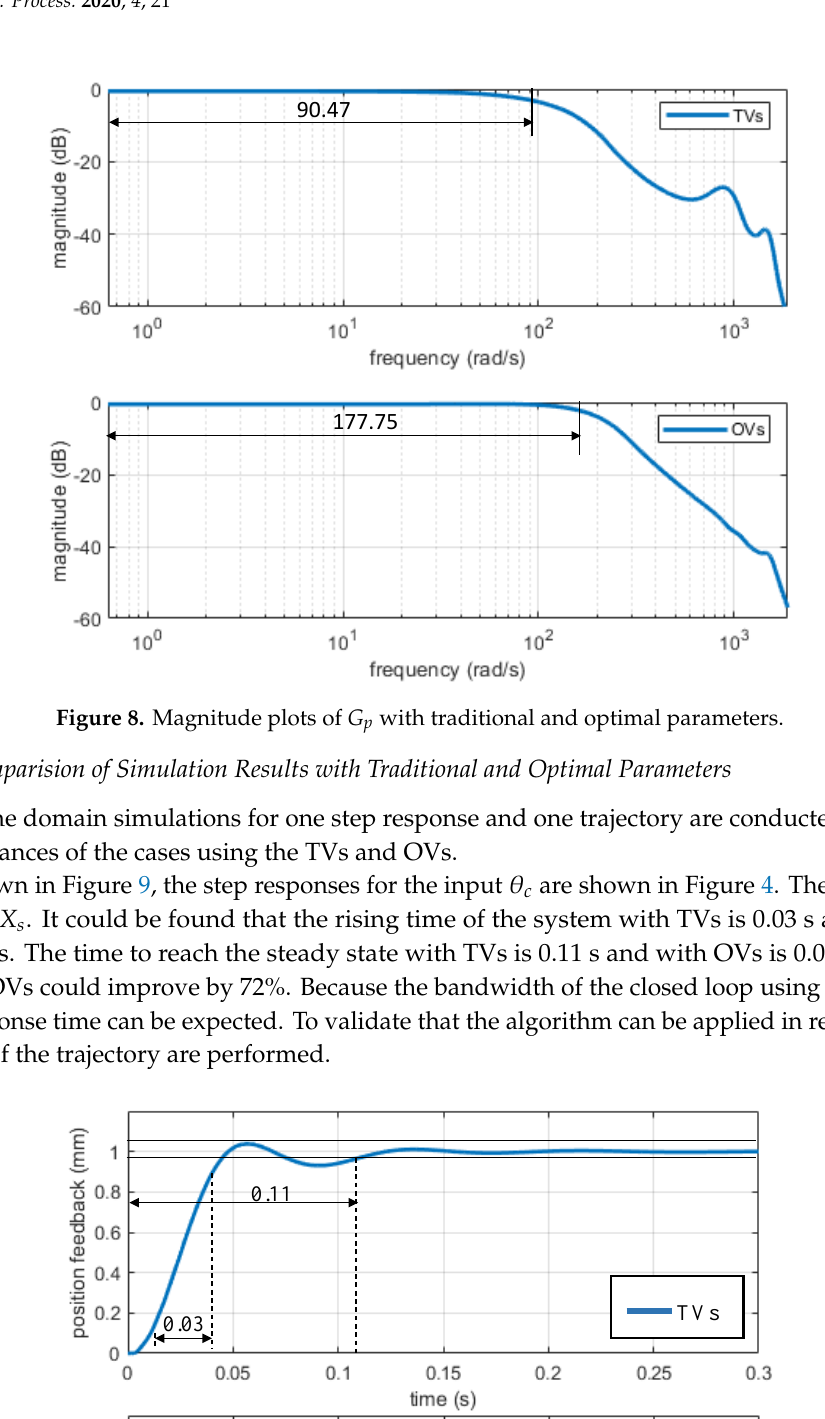
Figure 9. The step responses of optical scale feedback